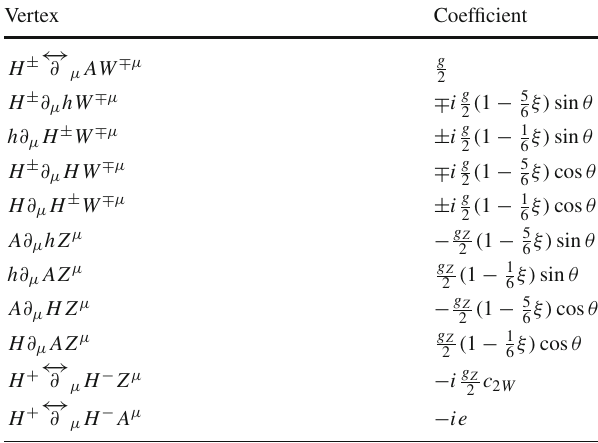
Table 3 Coefficients of the Scalar–Scalar–Gauge type vertices